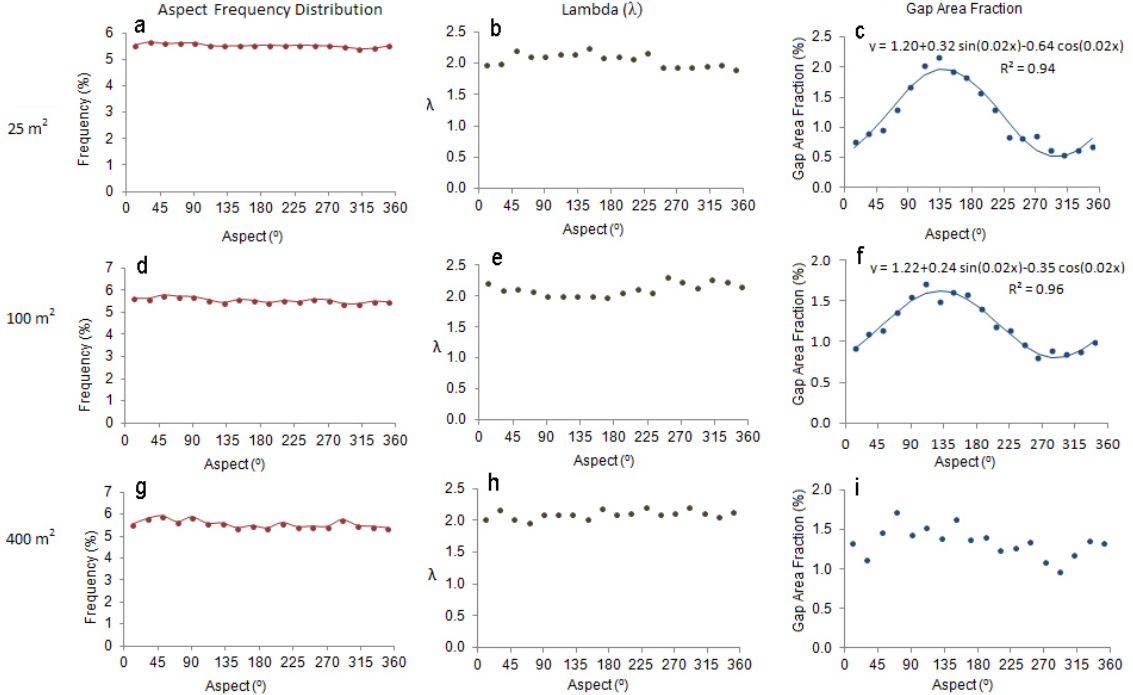
Fig. 5. The frequency distribution of aspects across the landscape (a, d, g) evaluated at three different scales: 25, 100, and 400m 2 , and the effect of aspect on the gap size-frequency distribution (b, e, h) and gap area fraction (c, f, i) .